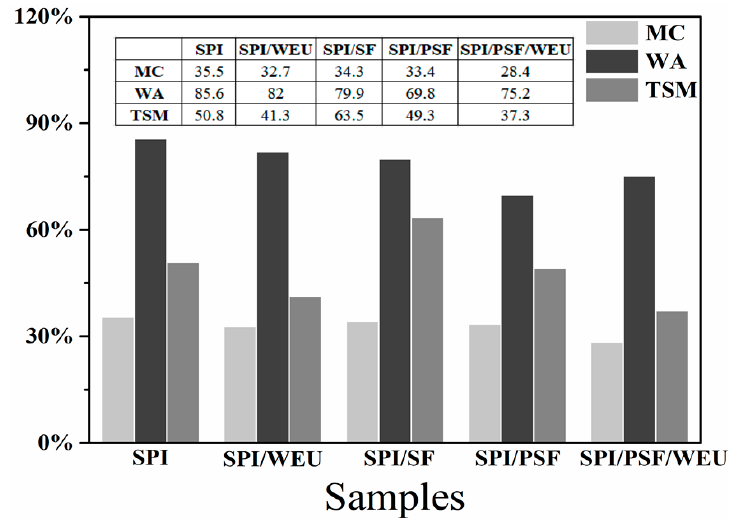
Figure 8. Moisture, water absorption, and total soluble matter of neat SPI, SPI/WEU, SPI/SF, SPI/PSF, and SPI/PSF/WEU films.